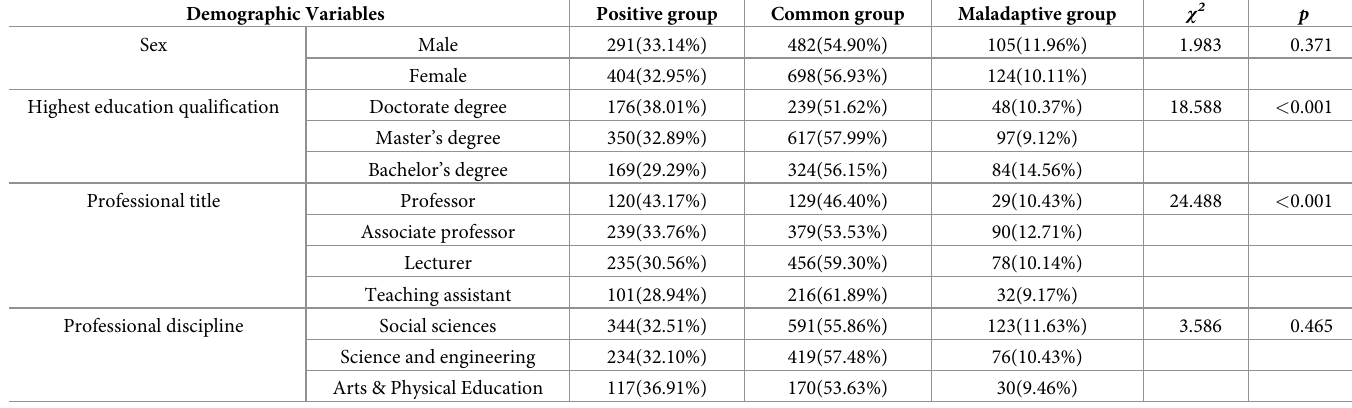
Table 2. Difference in potential profiles of psychological adaptation by